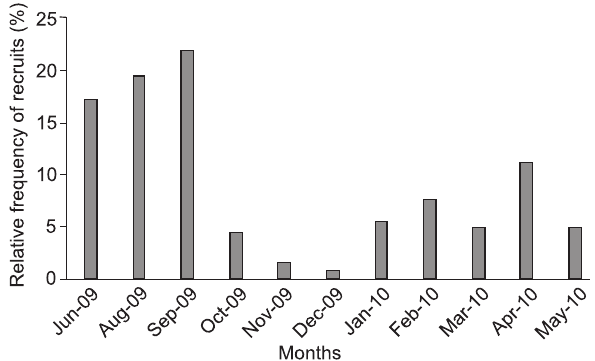
Figure 7. Relative frequency of recruits over 12 months (2009/2010).